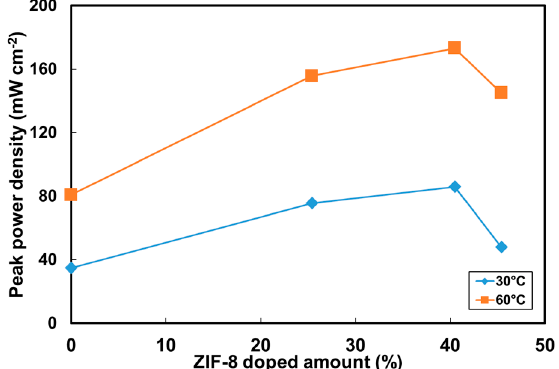
Figure 8. Effect of ZIF-8 loading on peak power density of DMAFCs. Gas diffusion electrodes: catalysts of 2 mg cm − 2 Pt–Ru (1:1) for anode and 1 mg cm − 2 Pt for cathode. Anode fuel: 2 M methanol + 6 M KOH at a flow rate of 5 mL min − 1 . Cathode fuel: humidified oxygen at a flow rate of 100 mL min − 1 .